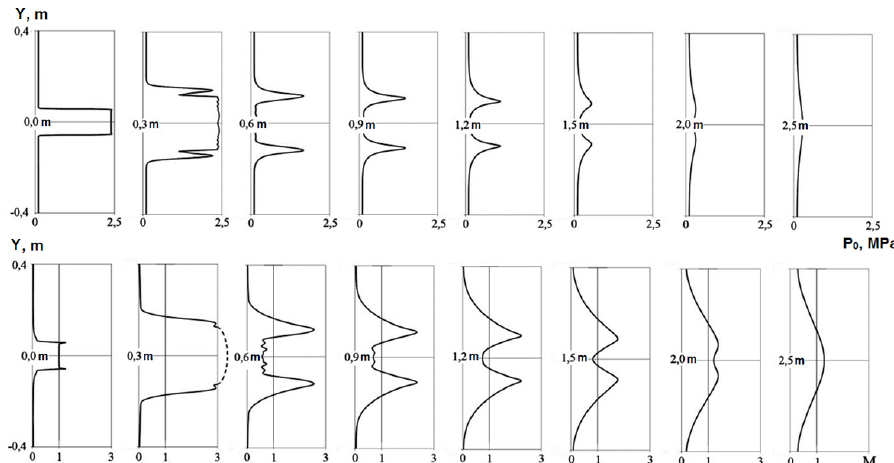
Figure 15. Distribution of the total pressure and Mach number in the cross sections over the stationary jet length for P 02 (0) = 2.35 MPa at the nozzle cut.